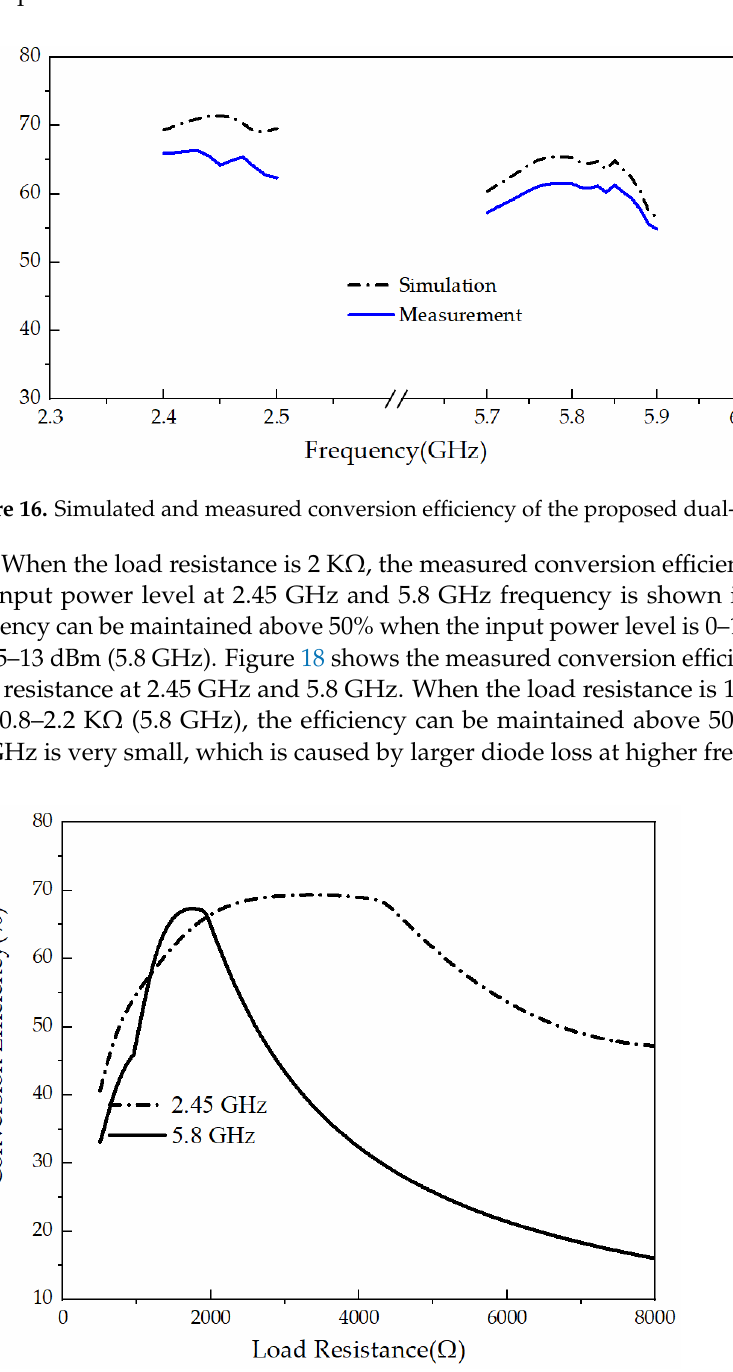
Figure 17. Measured conversion efficiency (Input power level is 10 dBm).